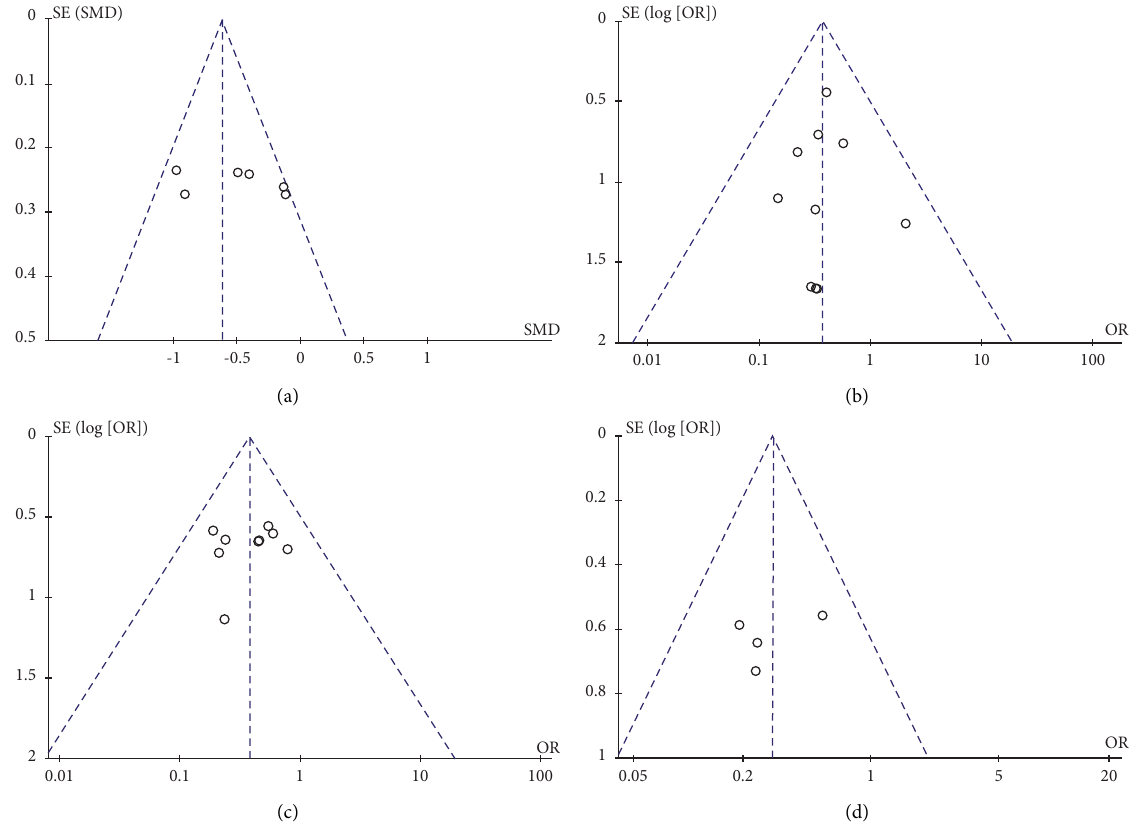
Figure 5: Funnel plots for (a) the serum TG level and the incidence of (b) premature birth, (c) hyperbilirubinemia, and (d) neonatal